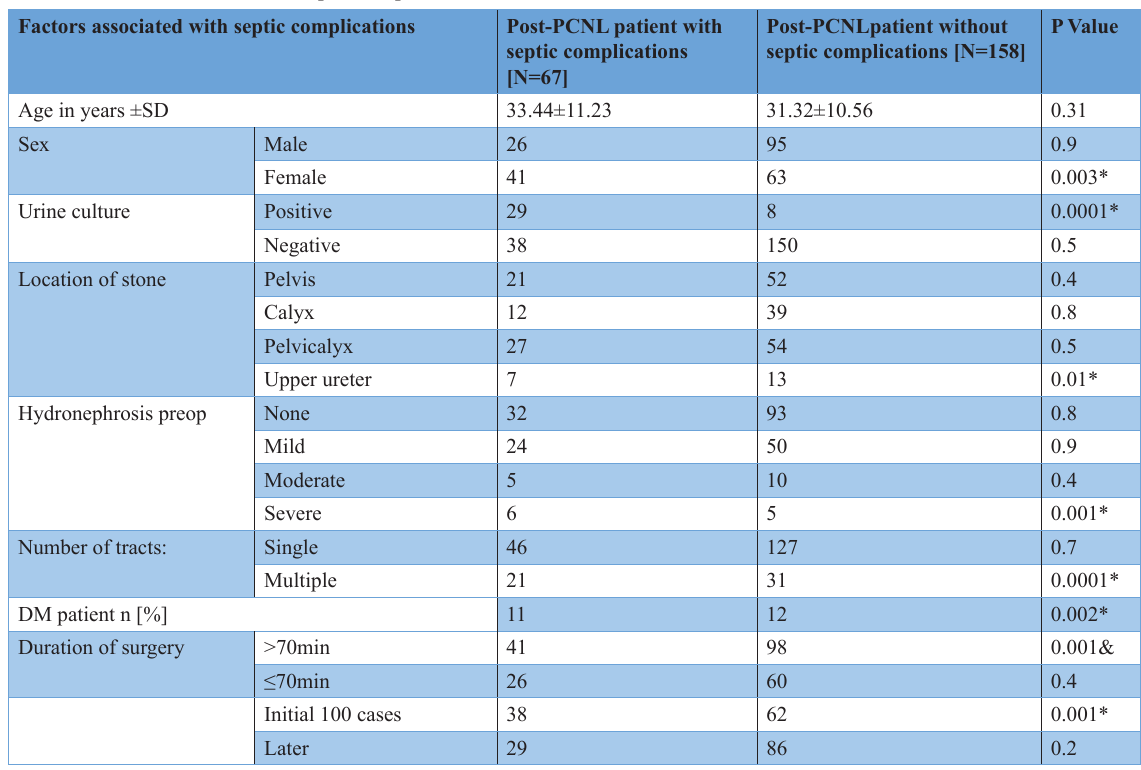
Table 3. Factors associated with septic